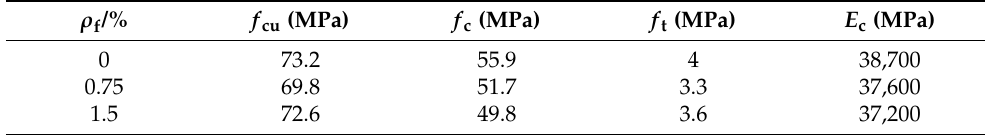
Table 3. Reinforcement’s mechanical properties . Table 2. Steel-fiber high-strength concrete’s mechanical properties.